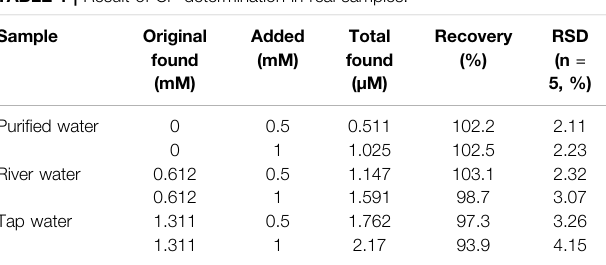
TABLE 1 | Result of Cl − determination in real samples.